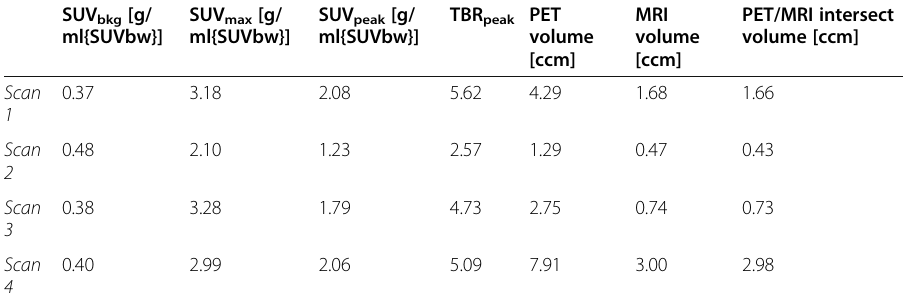
Table 2 Summary of static PET and volumetric PET/MRI cerebral tumour data for all four scans SUV bkg [g/ ml{SUVbw}]